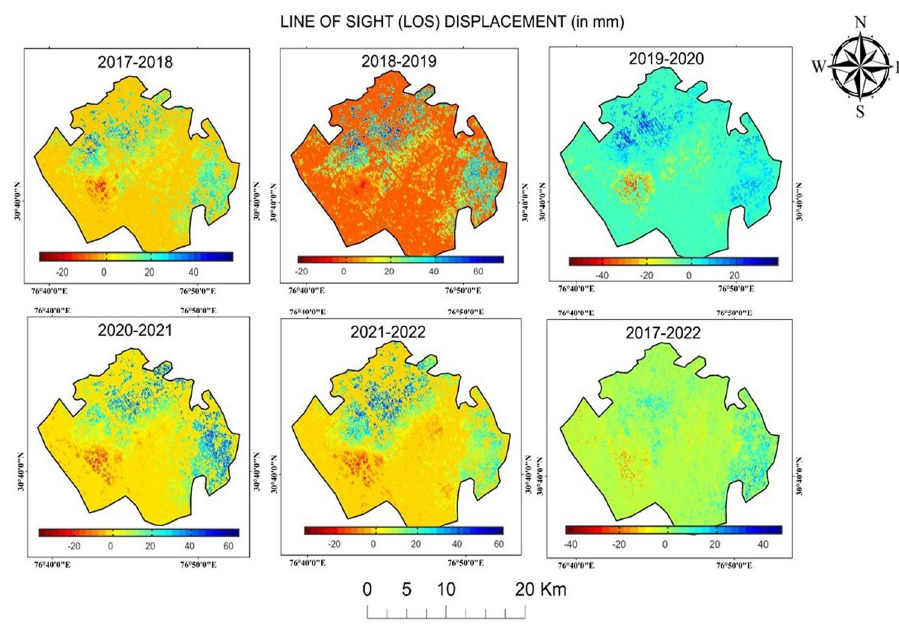
Figure 6. LOS displacements (in mm) for different time frames from 2017 to 2022. From Figure 6, it is observed that there were both positive and negative values of the LOS displacement. The PS points displaced away from the sensor showed negative values while the ones displaced towards the satellite sensor showed positive values. These LOS displacement values accounted for the urban surface subsidence. It is in- ferred from the above results that the maximum subsidence has been up to 4.0 cm or 40 mm from 2017 to 2022 towards the southwestern part of the study area. The Google Earth overlays of the urban surface subsidence of the Chandigarh tri- city region are shown in Figure 7.